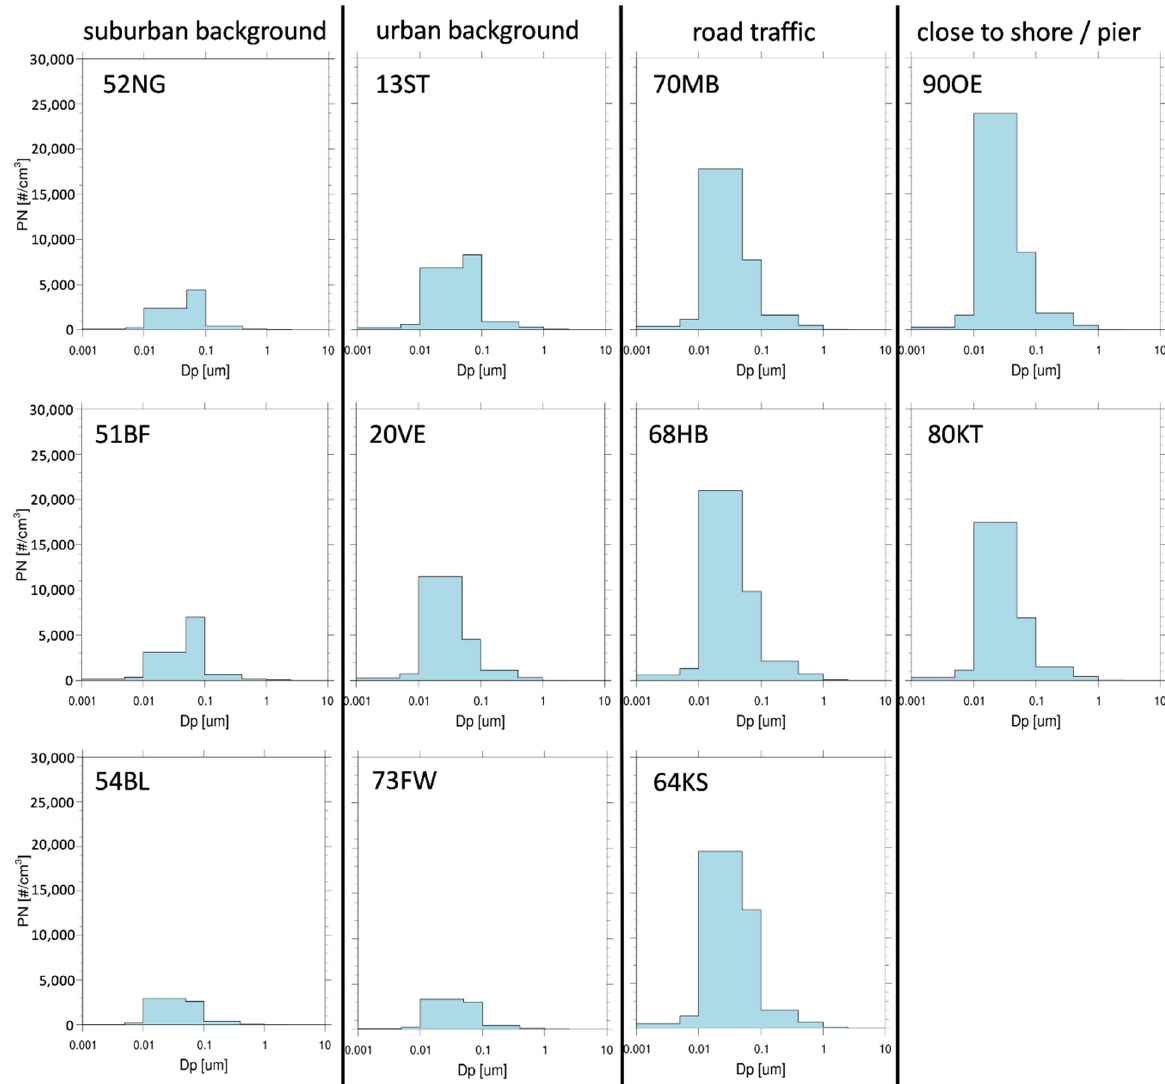
Figure 5. Modeled PN size distributions (on Day 5; 22 February 2021) according to the determined size classes at selected HaLM measurement stations sorted by station category. Top row shows the stations that were selected as PN measurements sites during the campaign. Stations were grouped into four categories: suburban, urban, road traffic and close to shore/pier. A list of the station acronyms is given in Table